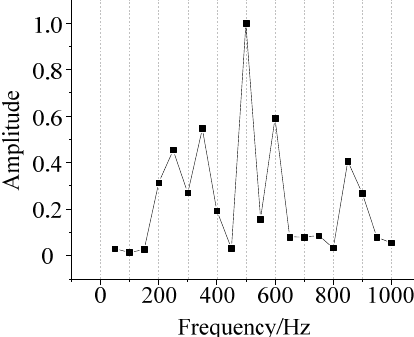
Figure 7. Frequency response function of oil and tank. According to the frequency spectrum of 500 kV transformer under DC bias and normal state, D(f) can be preliminarily obtained. After averaging and normalizing the three phase transformers of data in Figure 4, the calculated D(f) is shown in Figure 8.